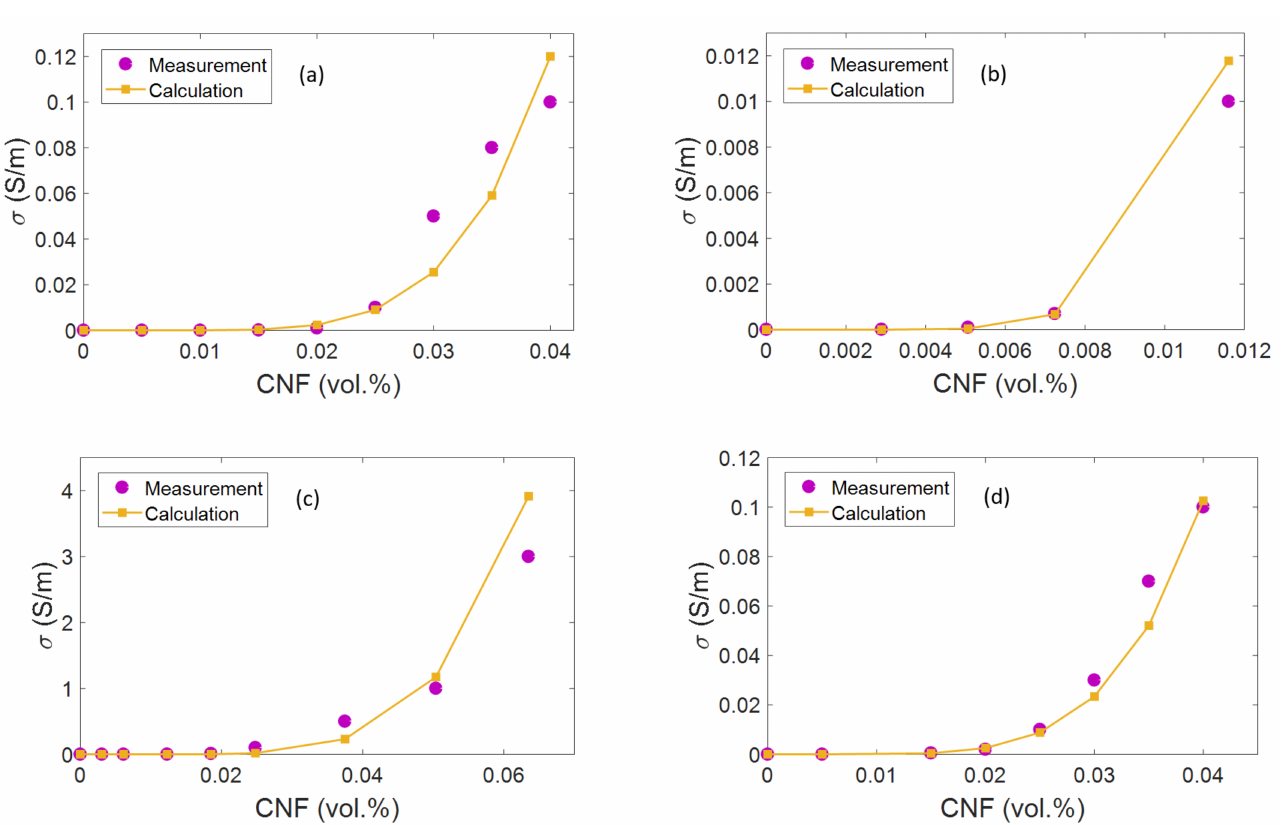
Figure 9. Agreement among theoretical and experimental data for ( a ) HDPE/CNF [79], ( b ) epoxy/randomly oriented CNF [80], ( c ) PMMA/CNF [81], and ( d ) HDPE/CNF [82]